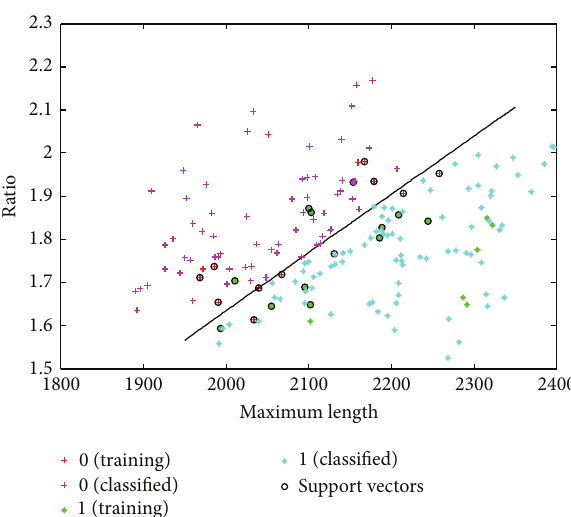
Figure 9: 10% as train and 84.57% identification accuracy.